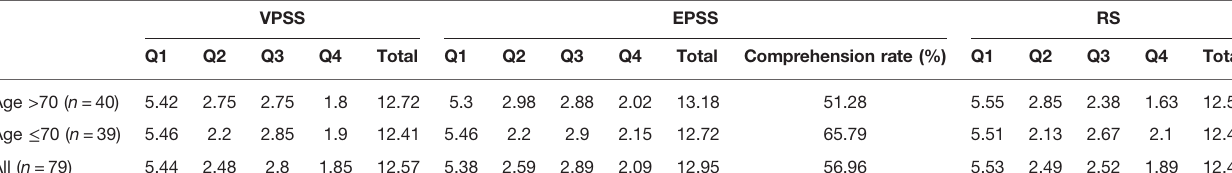
TABLE 2 | VPSS score, EPSS score, RS, and comprehension rate between two groups.